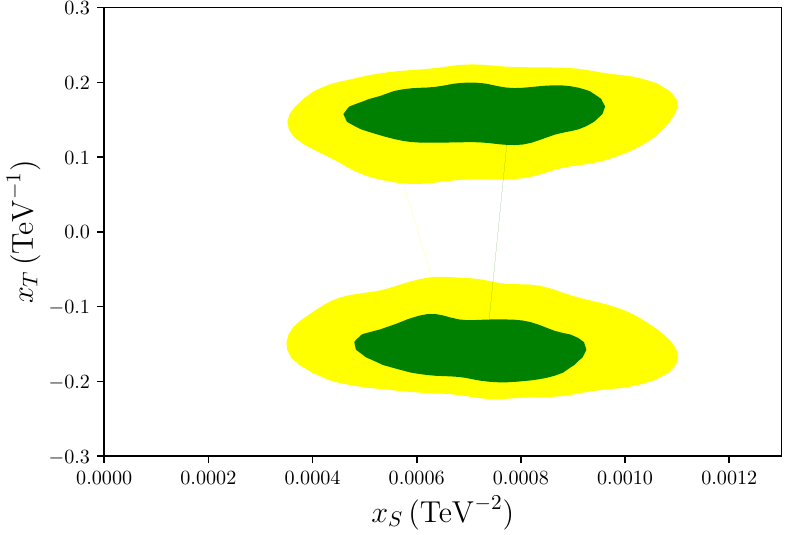
Figure 3 . The 1 (2)- σ regions in green (yellow) around the model’s best fit point. For each x S and x T point in the plot, the other couplings were marginalized in order to minimize the χ 2 . The observables included in the fit were the ones available in smelli in the classes EWPO, leptonic observables, lepton flavour universality for neutral currents and quark flavour observables, and (cid:15) µµ .